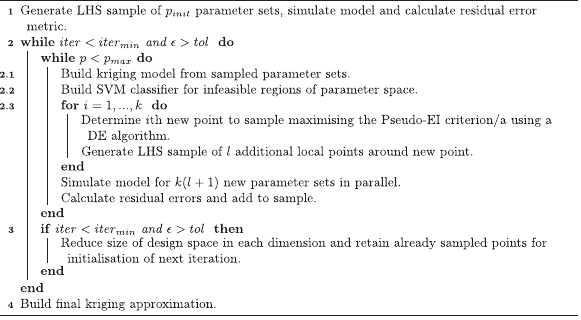
Frontiers in Pharmacology |